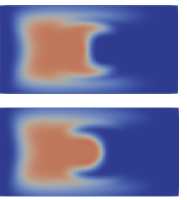
Figure 11. Adsorptive concentration at the outlet. With composite cosine pulsation, at t = 7.4 s ( top ) and t = 7.8 s ( bottom